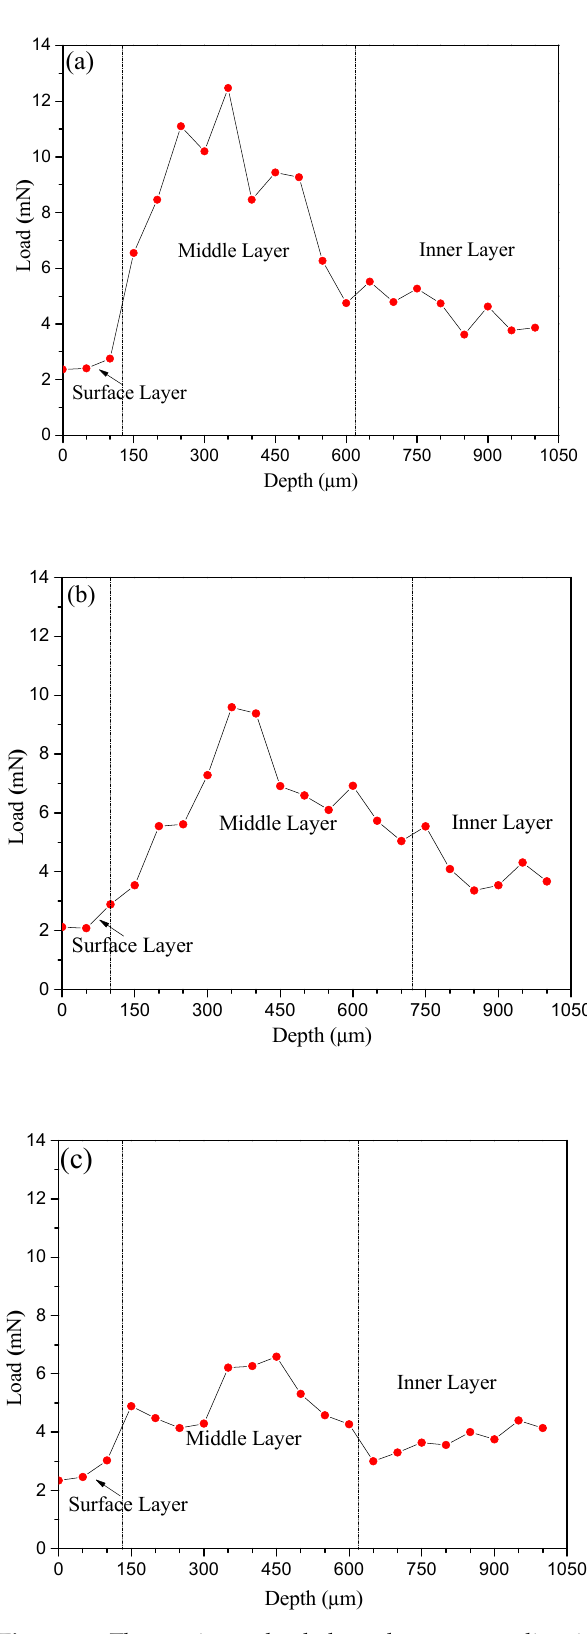
Figure 11. The maximum load along the transport direction from the surface to the inner part of specimens exposed to ( a ) Sc; ( b ) Ss, and ( c ) Scs. The three layers of each specimen are indicated by dotted lines in the plots and are consistent with the markings in Figure